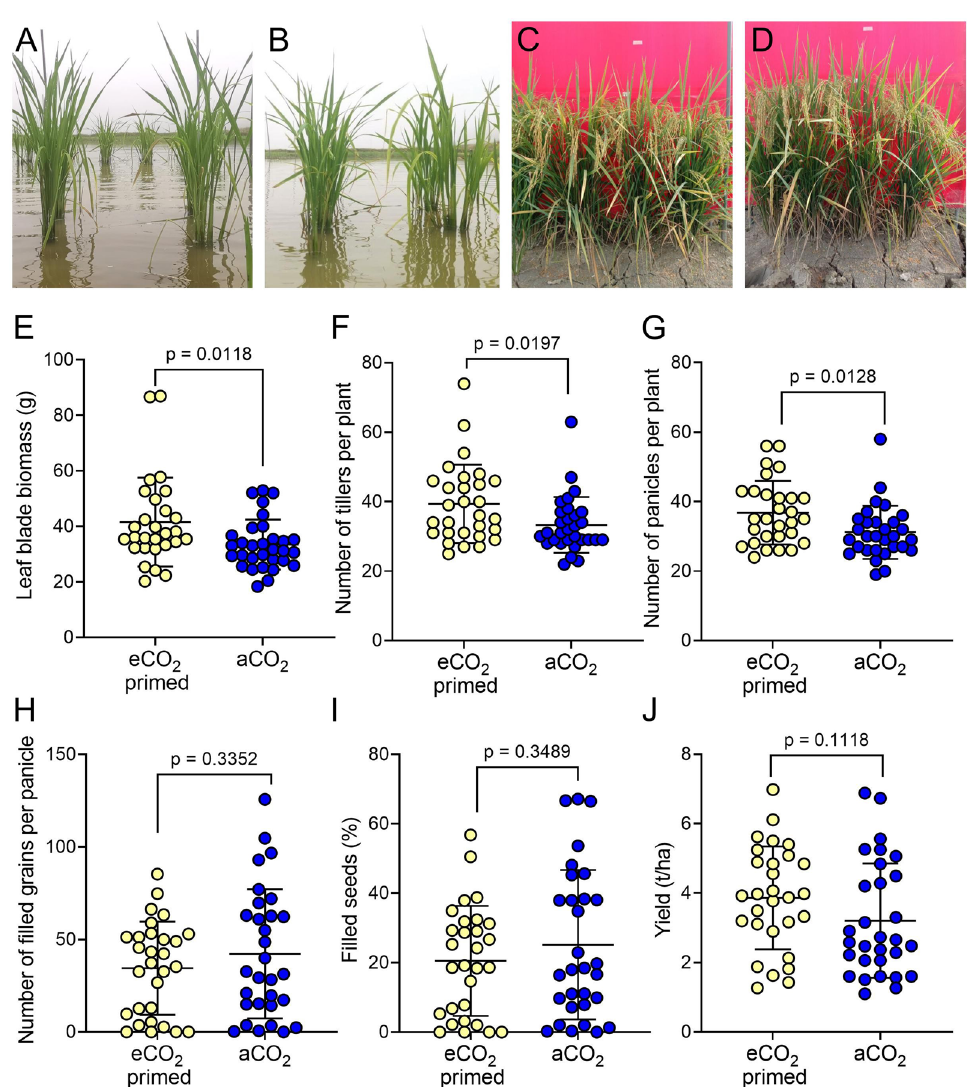
( E ), number of tillers per plant ( F ) and number of panicles per plant ( G ) are significantly higher in eCO 2 ‑primed plants. There is no difference in number of filled grains per panicle ( H ), percentage of seeds filled ( I ) or yield of rice grain per hectare ( J ) between the treatments. E Mann–Whitney U test, p 0.0118, n 29/30; F – J Unpaired t tests, p values as shown, n = =